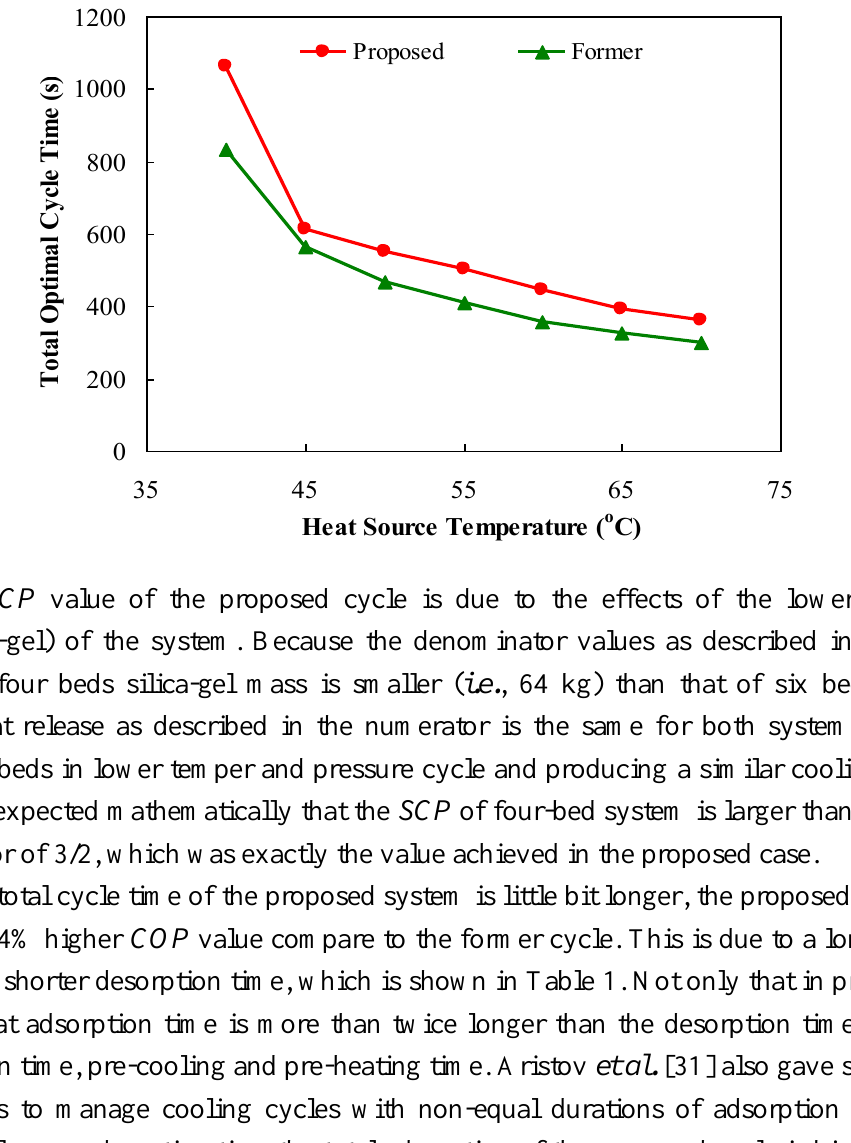
Figure 11. Comparison of optimal cycle time of proposed cycle with the former six-bed three-stage